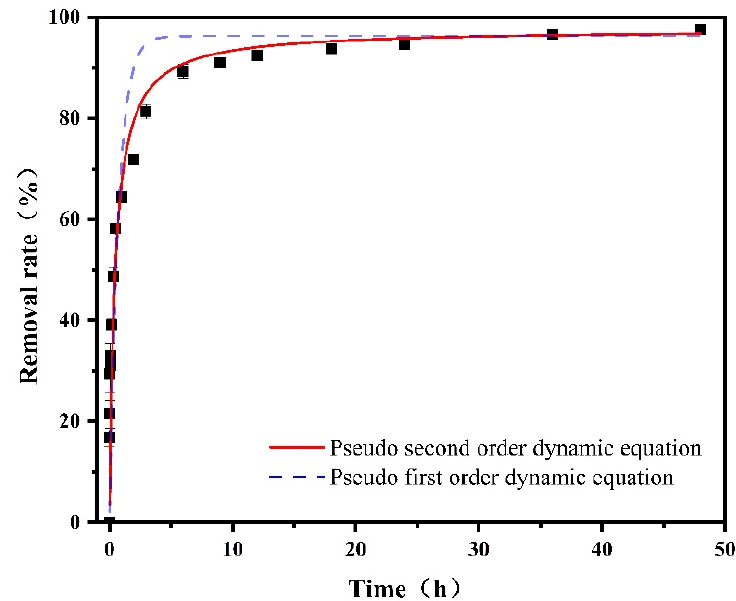
Figure 14. Kinetics fitting curve of PNP degradation by Co-nZVI/GAC activated PS.